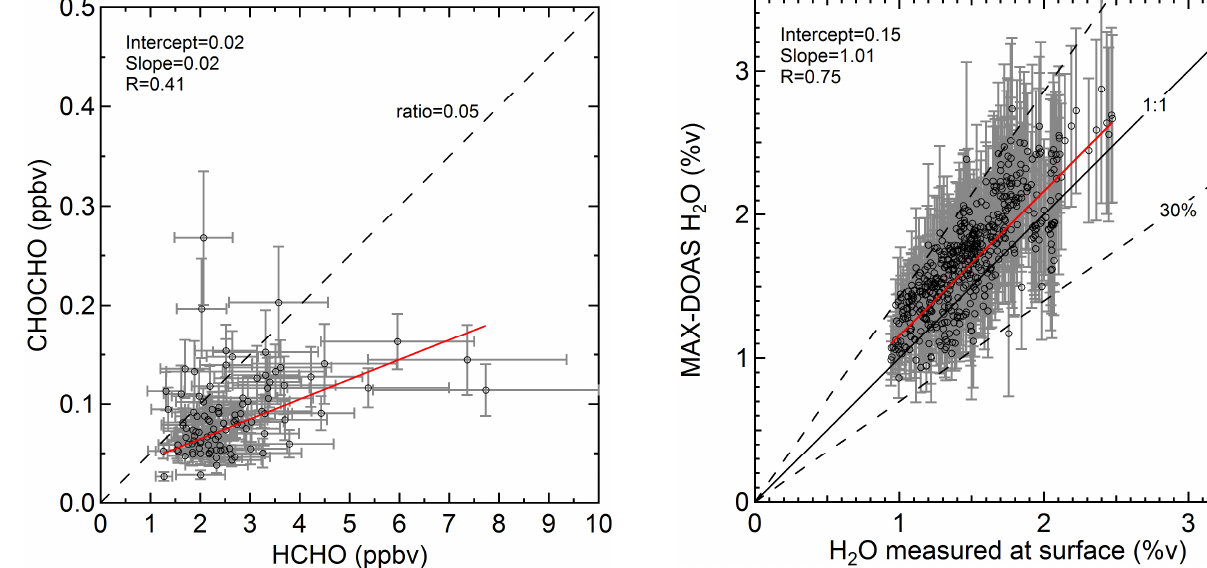
Fig. 11. Correlations between CHOCHO and HCHO VMRs retrieved from MAX-DOAS. The linear least-squares fit taking into account error ranges for both CHOCHO and HCHO is shown with the red line.